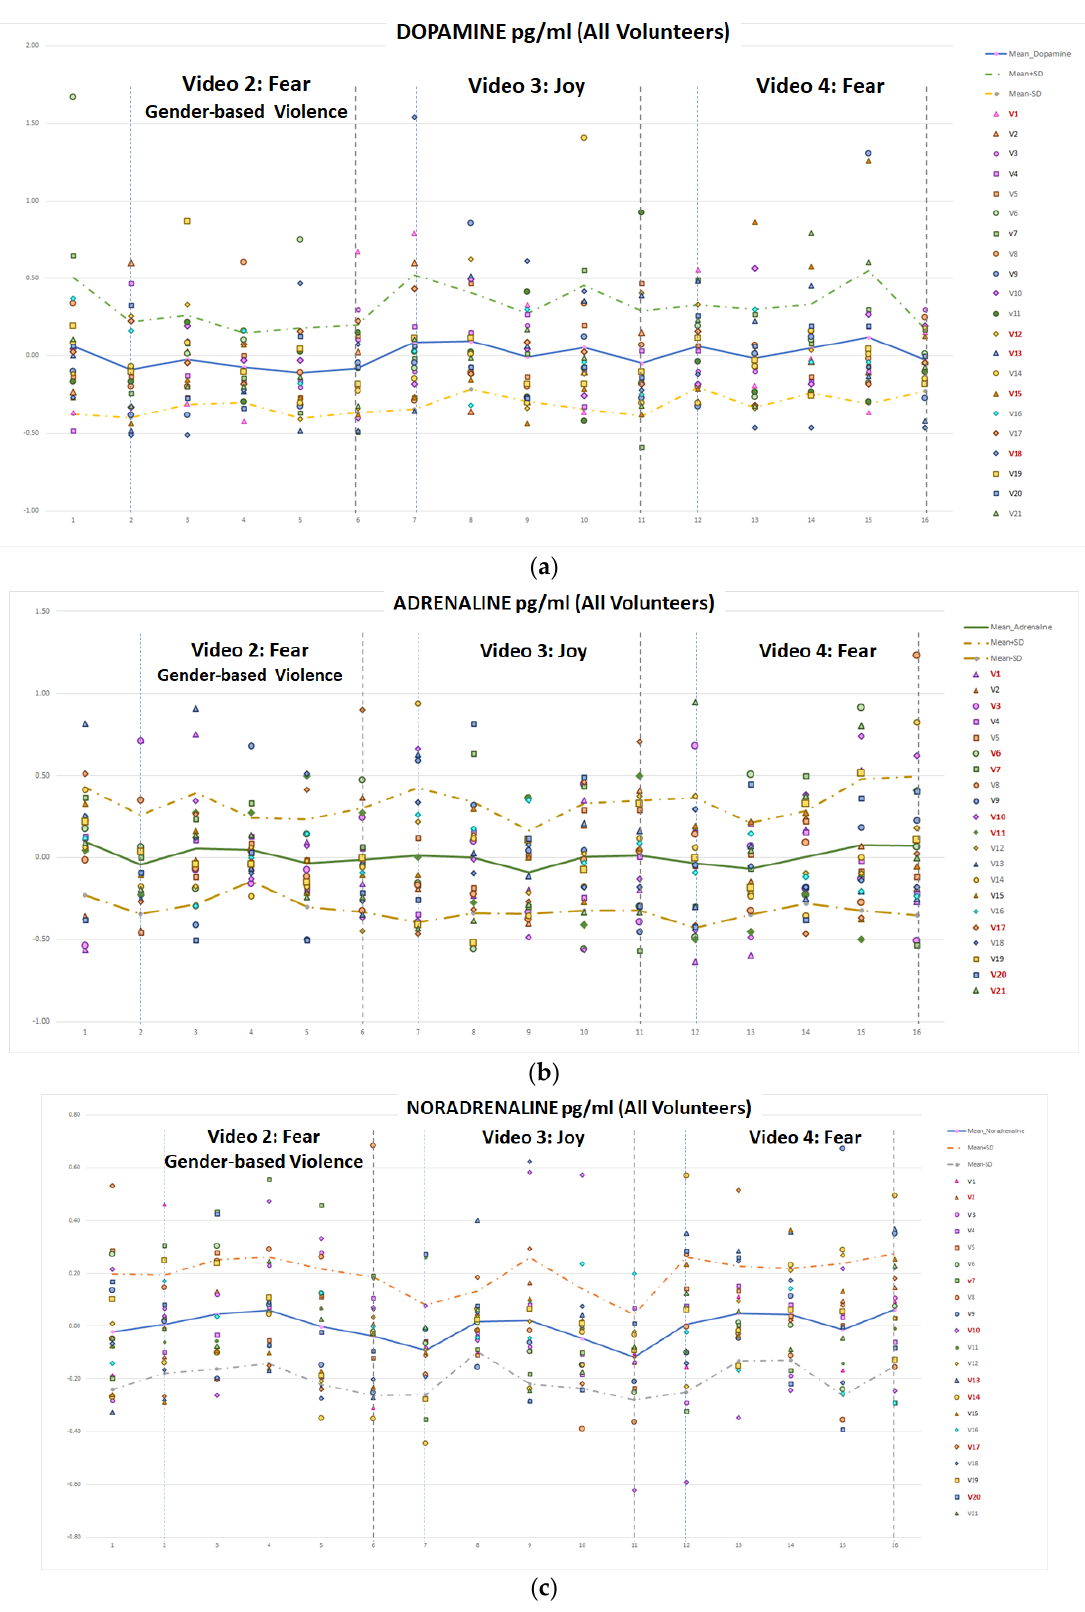
Figure 16. Temporal evolution of normalized catecholamine concentration for video clips 2, 3 and 4 for DA ( a ), A ( b ) and NA ( c ).